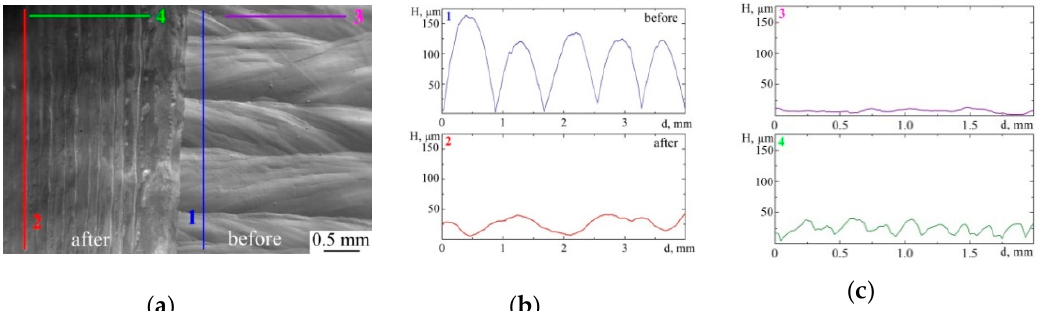
Figure 3. SEM image ( a ) and corresponding profiles directed parallel ( b ) and perpendicular to the build direction ( c ) of the EBF 3 -fabricated Ti–6Al–4V sample before (profiles 1, 3) and after scanning electron beam treatment (profiles 2, 4).